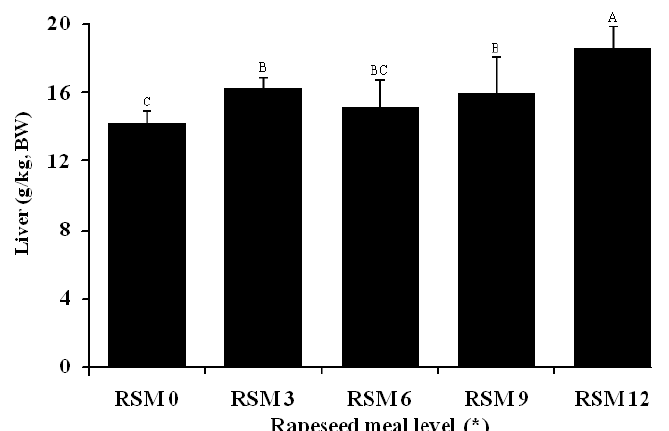
Figure 2. Influence of dietary rapeseed meal (RSM) utilization on liver weight at 13th wk of finishing pigs (* linear, p<0.01). A,B,C means with different superscripts within the same row significantly differ